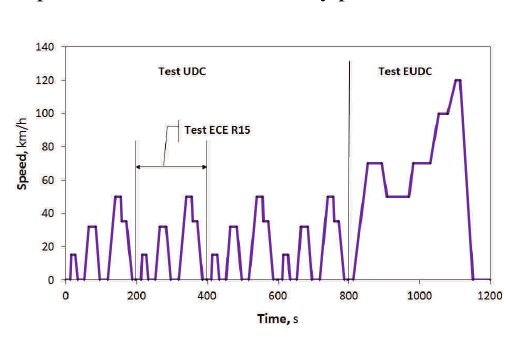
Fig. 3. The profile of NEDC test speed